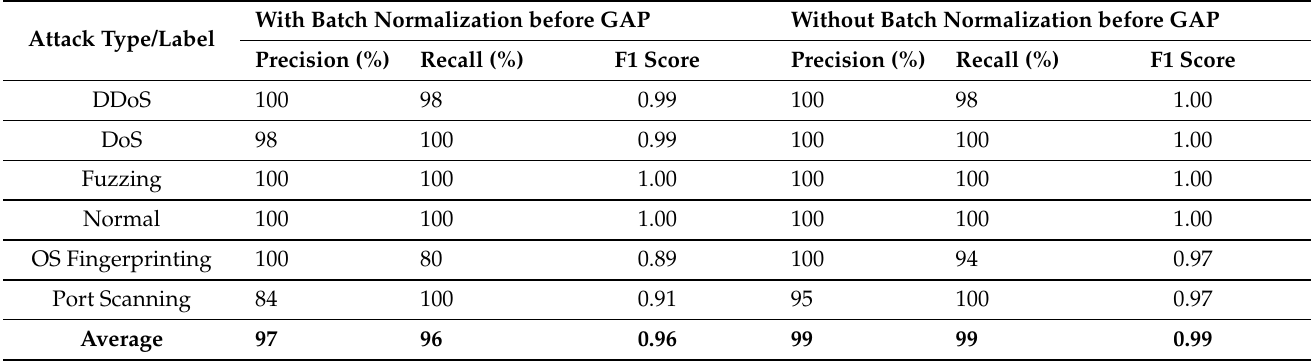
Table 5. The 3 × 3–5 × 5 with and without batch normalization before the global average pooling.